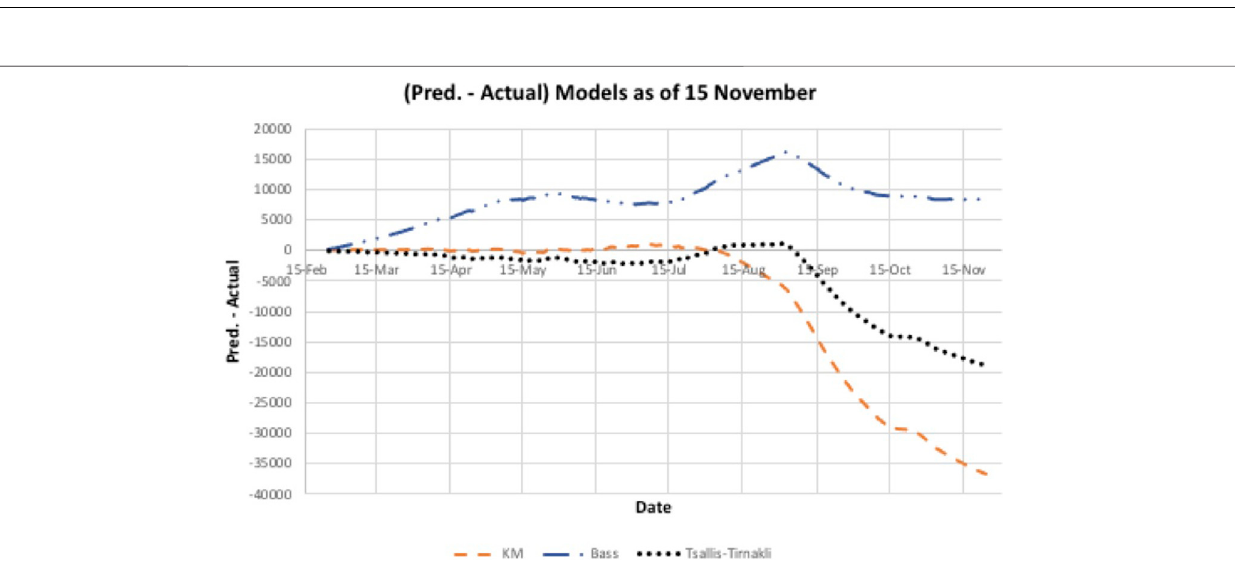
FIGURE 5| Underestimated/overestimated Model prediction for Bahrain data. However, the Bass model appears toconvergeto abetter estimate of sizethan the other two models.